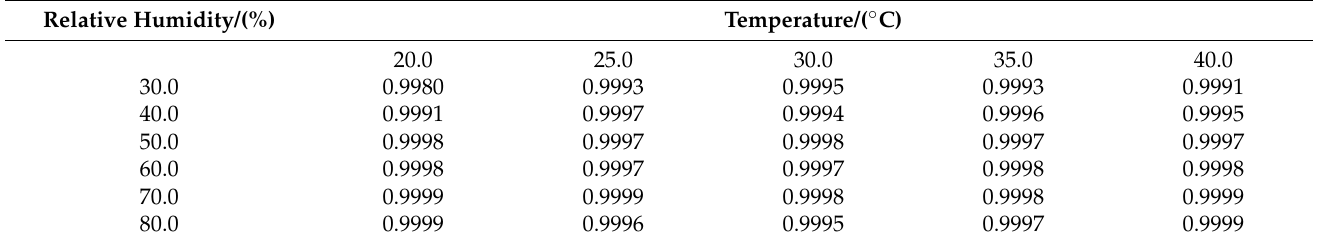
Table 5. Correlation coefficients for calibration curves measured under isothermal/isohume conditions.